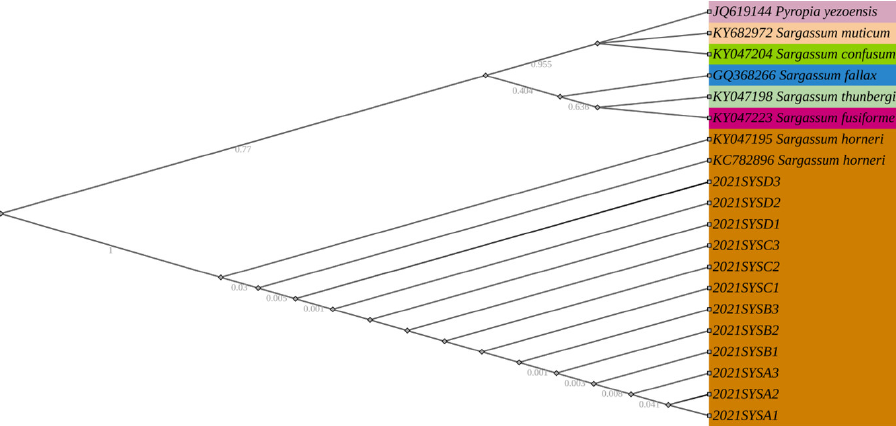
Figure 3. MCL phylogenetic tree of the golden tide macroalgae analyzed in this study; 1000 bootstrap replicates were used to verify the support rate of each node in this tree.